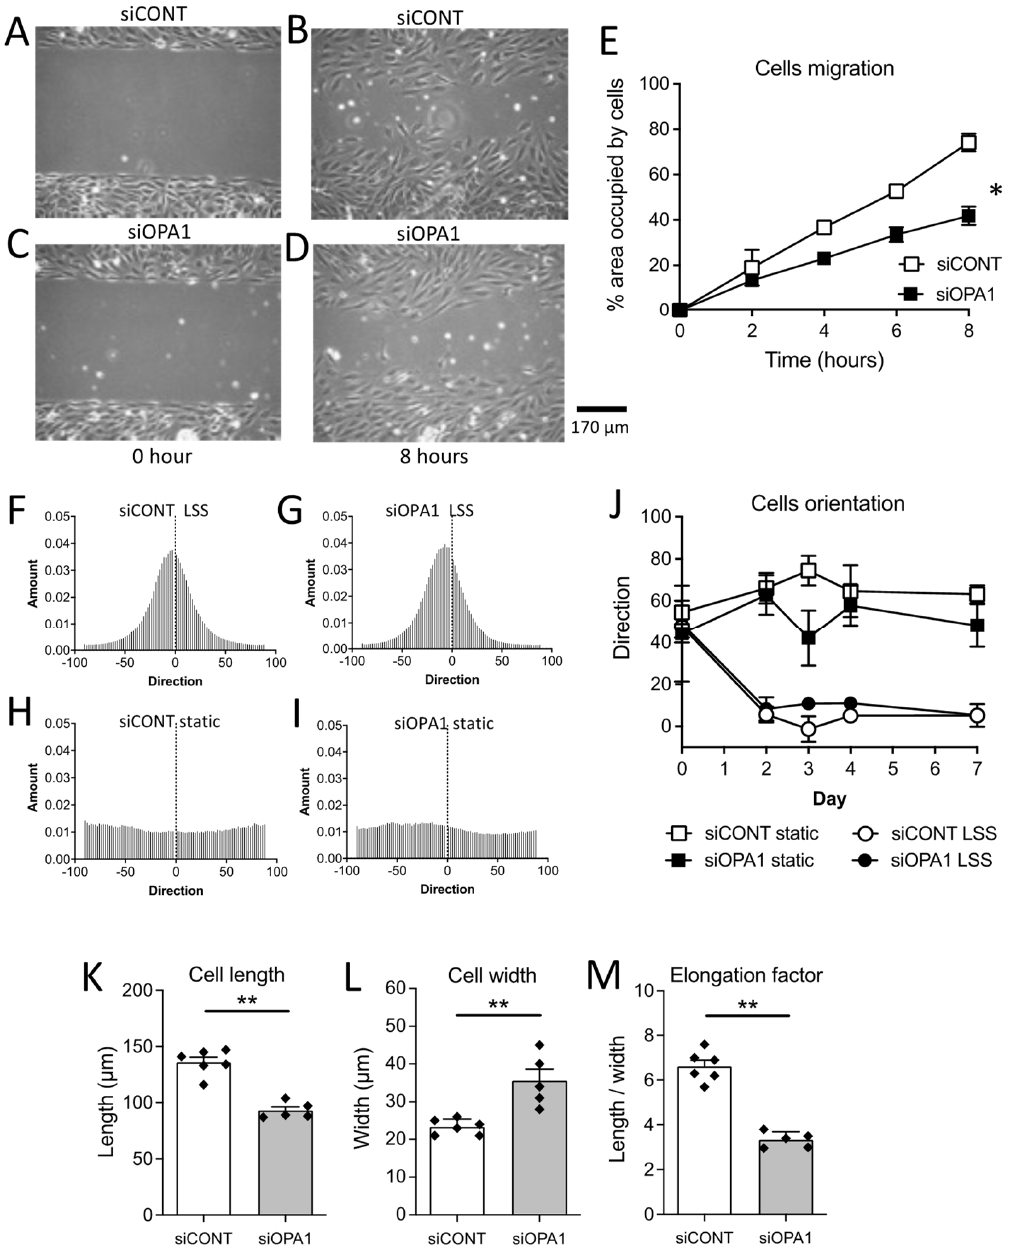
Figure 1. EC migration and flow-mediated EC alignment and elongation. Endothelial cells (HUVECs) were transfected for 72 h with the control scrambled siRNA (siCONT, A , B ) or siOPA1 ( C , D ) and seeded in Ibidi ® µ -slides attachment (Ibidi, Munich, Germany). Cells were allowed to migrate, and imaged at different time points. Data are expressed as the area occupied by cells after each time point ( E ). Means ± SEM are shown (n = 3 independent experiments per group). Endothelial cell alignment ( F – J ) was determined after exposure to laminar flow (laminar shear stress, LSS, 20 dyn/cm 2 , 3 days, F , G ), compared to static conditions ( H , I ). Quantification of cells’ orientation are shown in panel J. The cell elongation factor ( M ) was determined as the cell length ( K ) along flow direction divided by cell width ( L ). Means ± SEM are shown (n = 5 siOPA1 or 6 siCONT independent experiments per group for alignment and elongation measurements). Two-way ANOVA for repeated measurements ( E , J ): Panel E : * p = 0.0214 (interaction: p = 0.0001). Panel J : cell alignment (static versus flow in siCONT and siOpa1 cells). Panel J : NS, siCONT static versus siOpa1 static and siCONT flow versus siOpa1 flow. ** p = 0.0043, two-tailed Mann–Whitney test, panels K , L and M .